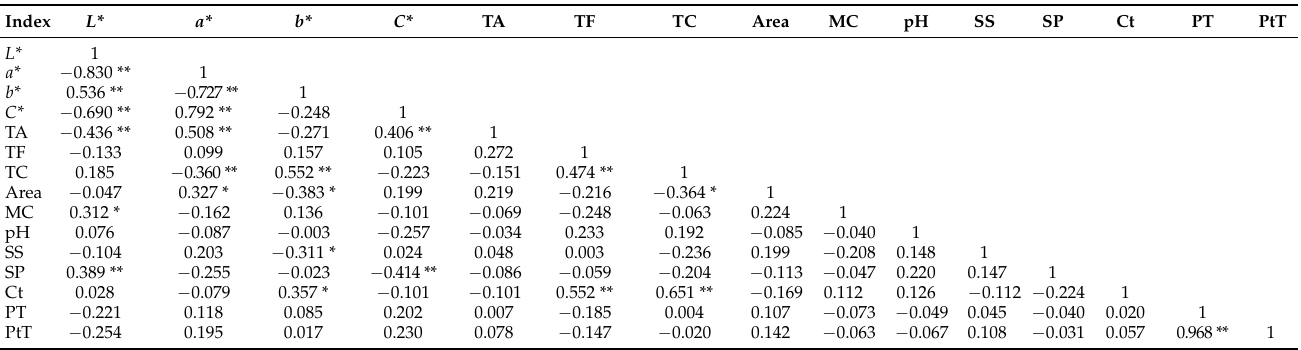
Table 6. Correlation analysis of physiological indexes in herbaceous peony